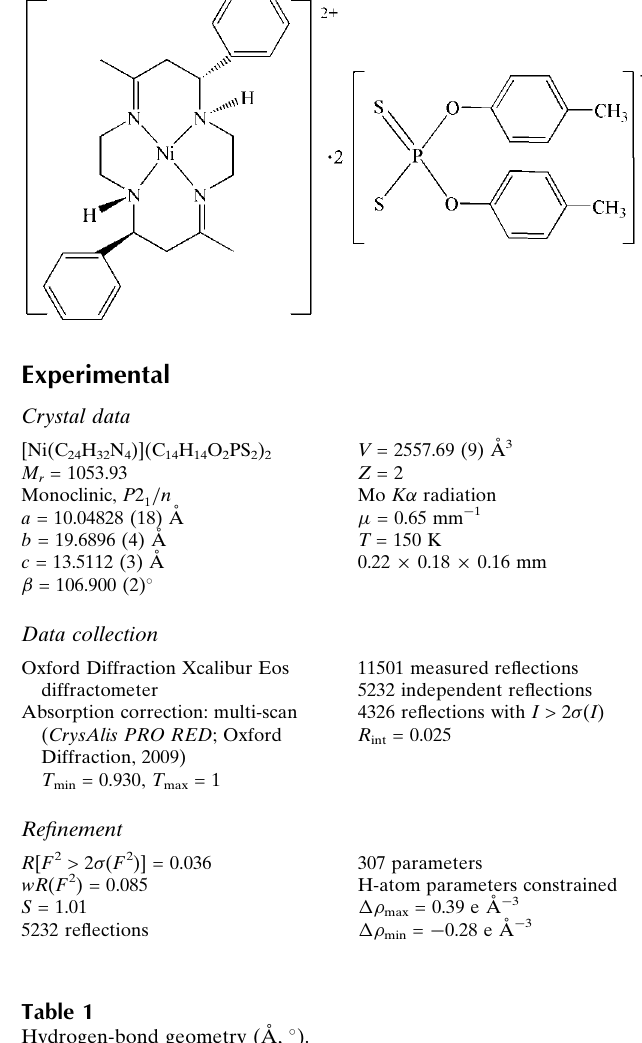
Hydrogen-bond geometry (A˚ , (cid:3) ). D —H (cid:2)(cid:2)(cid:2)